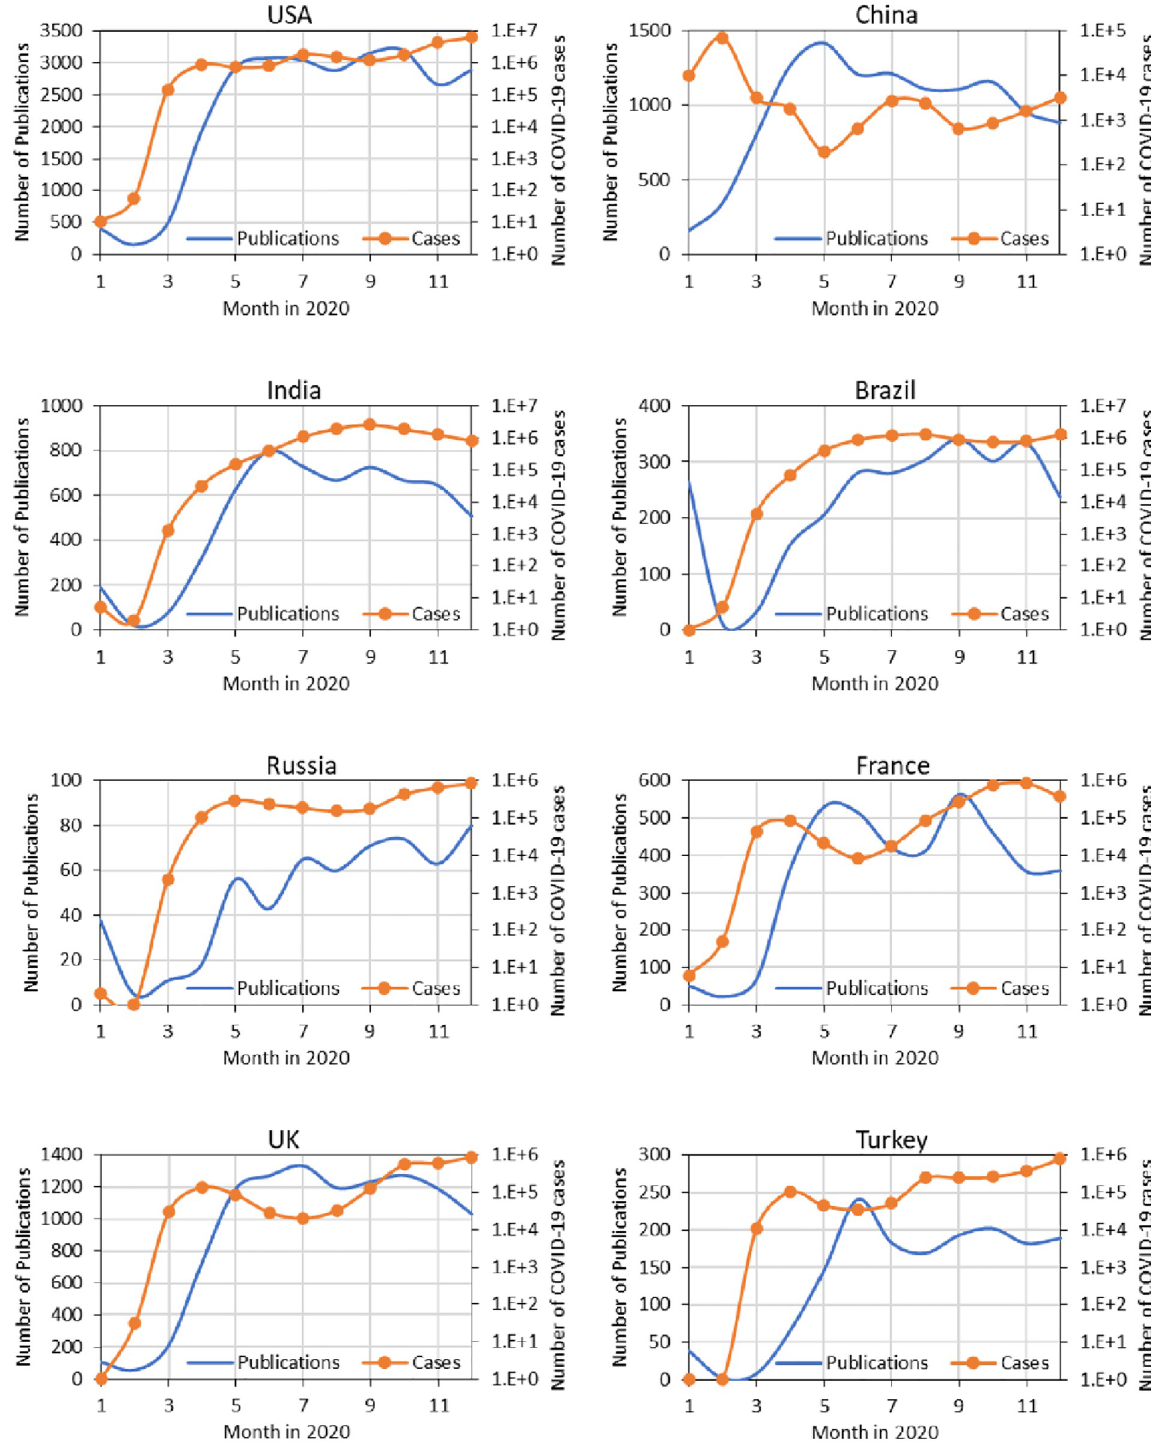
Fig 3. Number of publications and COVID-19 cases for selected countries by month in 2020.